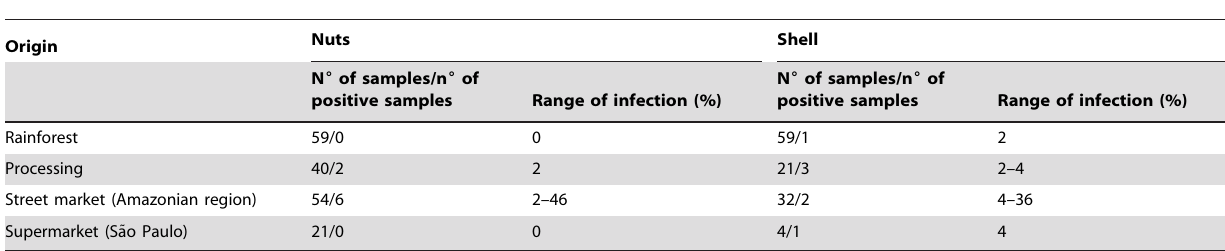
Table 2. Incidence of A. bertholletius in brazil nut samples.